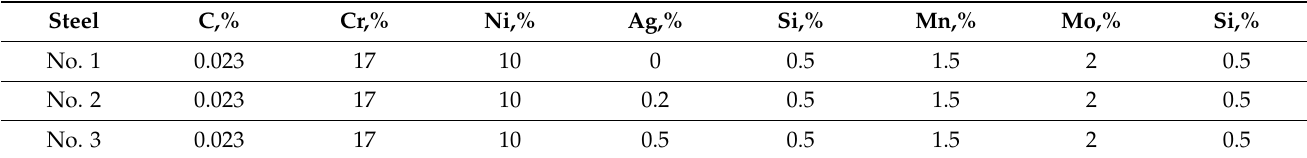
Table 1. Chemical composition of steels